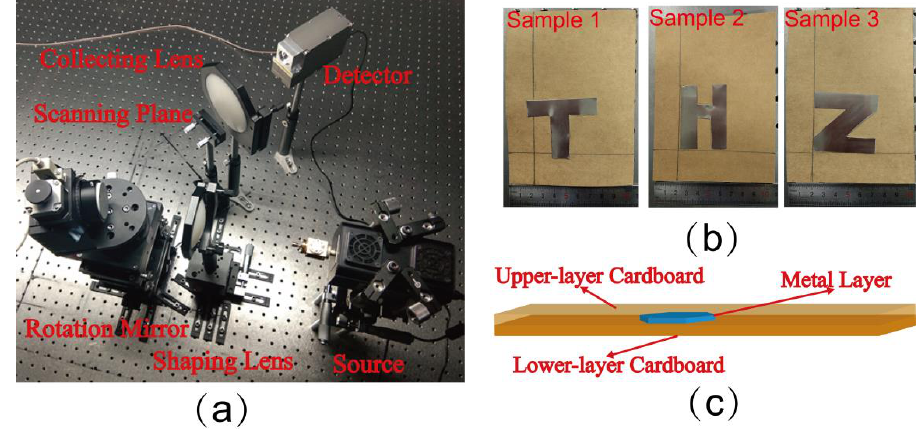
Figure 5. ( a ) is a photograph of our THz rotation mirror imaging system; ( b ) shows photographs of three samples’ metal layer hidden behind the upper layer of cardboard; ( c ) is a schematic of the samples’ structure.